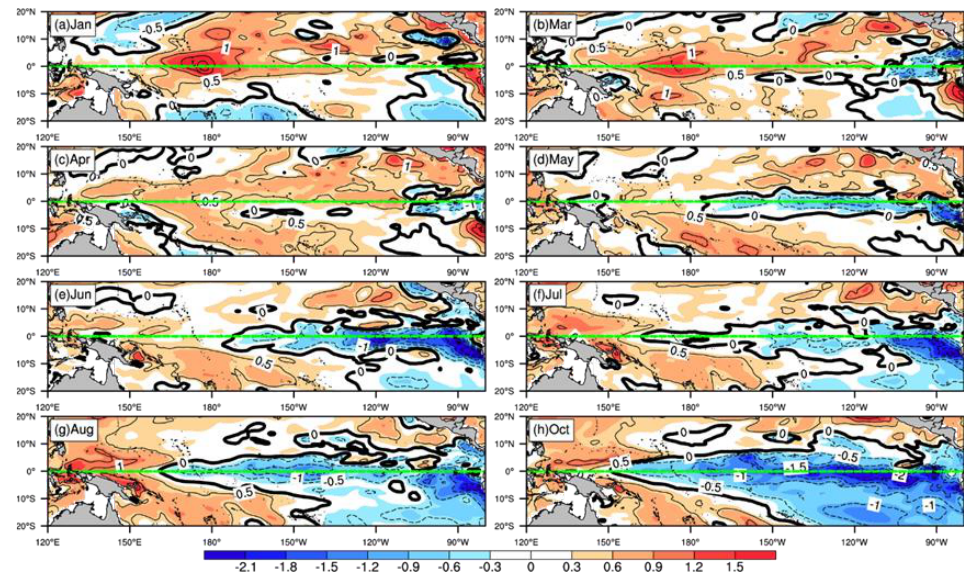
Figure 3. The spatial distribution of SST anomalies in January, March, April, May, June, July, August, and October 2020. The green line marks the equator. The contour interval is 0.5 °C.